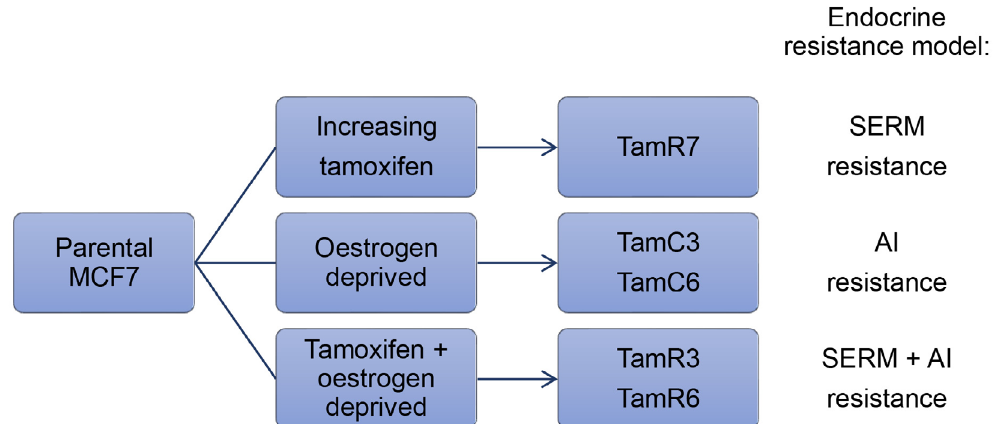
Figure 1. Summary of conditions used to generate endocrine therapy-resistant MCF7 sublines and the clinical relevance of the